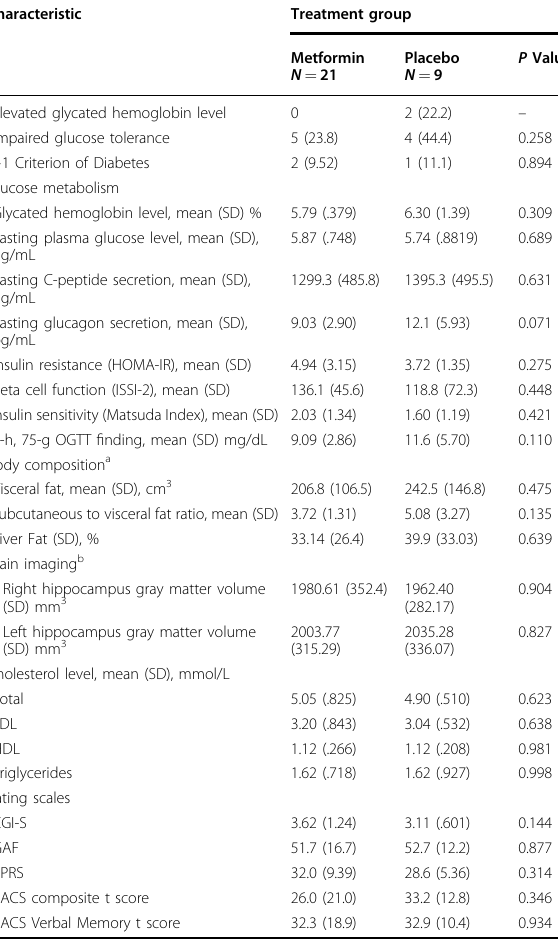
BMI body mass index (calculated as weight in kilograms divided by height in meters squared), BPRS Brief Psychiatric Rating Scale, BACS Brief Assessment of Cognition in Schizophrenia, CGI Clinical Global Impressions Scale severity score, GAF Global Assessment of Functioning scale, HDL high-density lipoprotein, LDL low density lipoprotein, SD standard deviation. a Body composition outcomes were available for 18 participants in the metformin arm and 9 in the placebo arm. b Brain imaging outcomes were available for 18 participants in the metformin arm and 7 in the placebo arm at